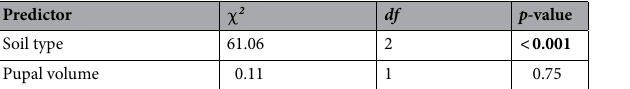
Table 1. Pupation depth—generalised linear mixed effect model (family = binomial, link = logit, random factors: “Box/pupae volume”, “mean temperature”) examining the effect of soil type and pupal volume on the proportion of larvae ( D. suzukii ) pupating in the upper soil layer. Significant values are in bold.